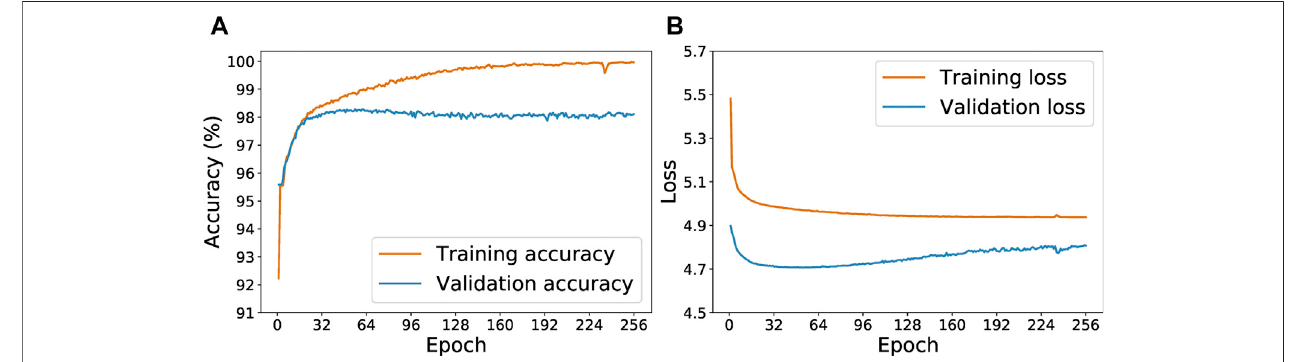
FIGURE 5 | Evolution of the training and validation accuracy (A) and loss (B) as the Keras-LSTM model is trained for from 1 to 256 epochs.